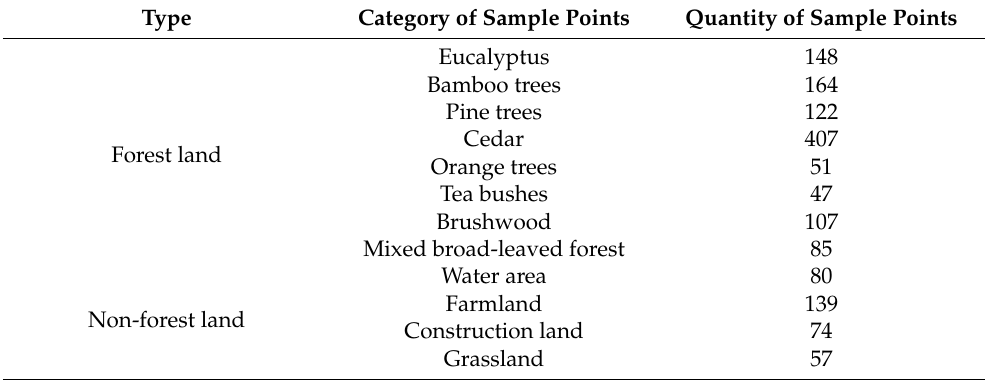
Table 2. Category and quantity of sample points.